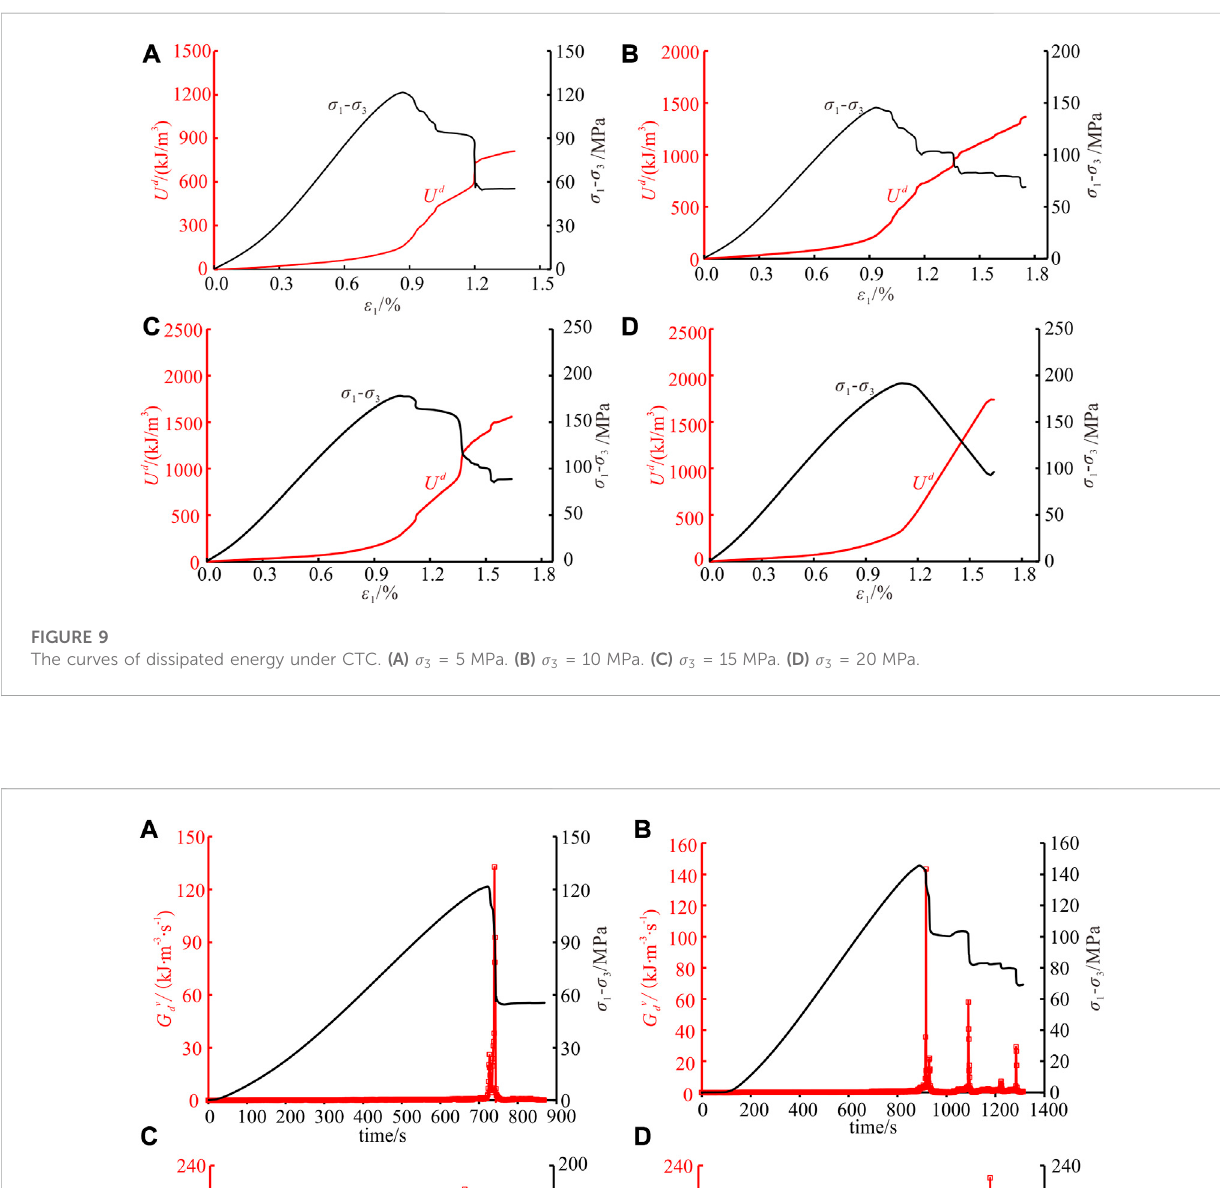
Frontiers in Earth